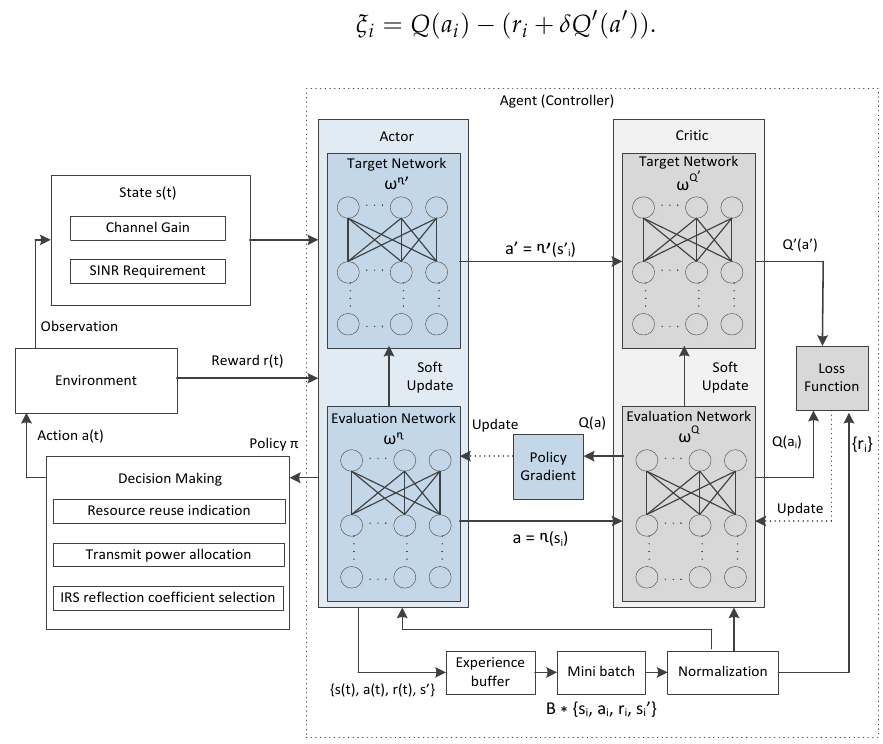
Figure 3. The actor-critic framework based on the DDPG